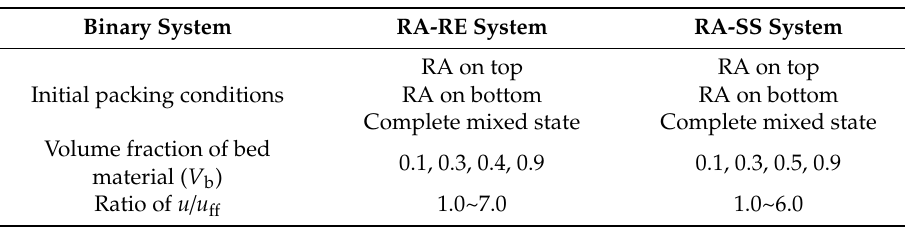
Figure 2. Schematic diagram of the stepwise sampling method. Table 2. Experimental conditions.